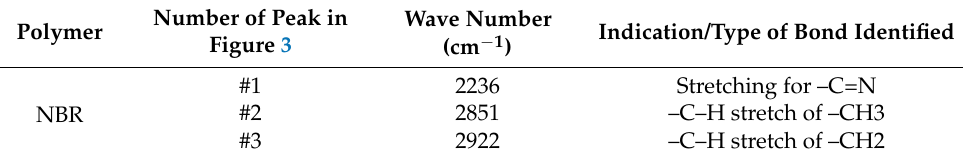
Figure 3. FTIR spectra. Table 2. Characteristic bonds of NBR as a function of wave number in the Fourier transform infrared spectroscopy test [38].